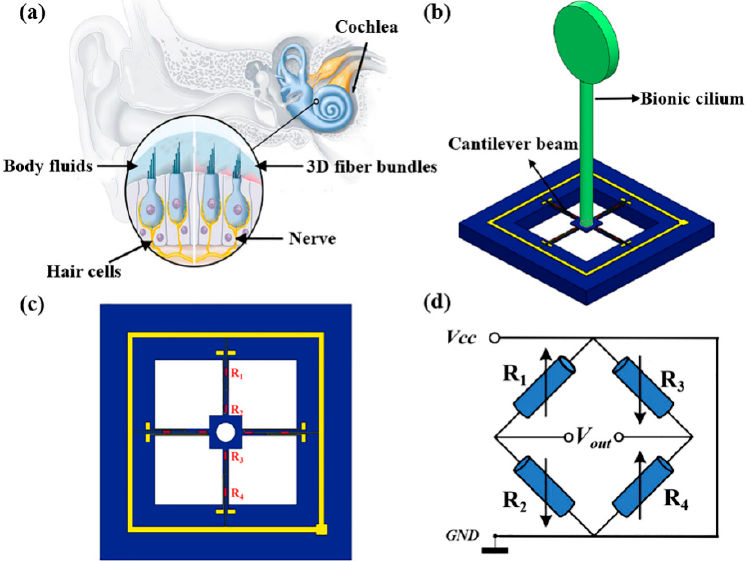
Figure 1. ( a ) Mechanism of human hearing. ( b ) Micro-structure of biomimetic MEMS. ( c ) Schematic diagram of cantilever beam structure. ( d ) Wheatstone bridge.